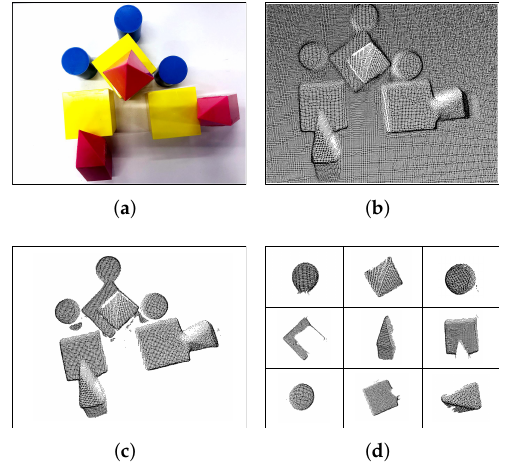
Figure 2. Point Cloud segmentation of stacked objects. ( a ) the object appearance seen from RGB camera. ( b ) the original point cloud read from depth camera. ( c ) pre-processes point cloud via passthough filter, RANSAC and outlier removal. ( d ) the point cloud segmented by